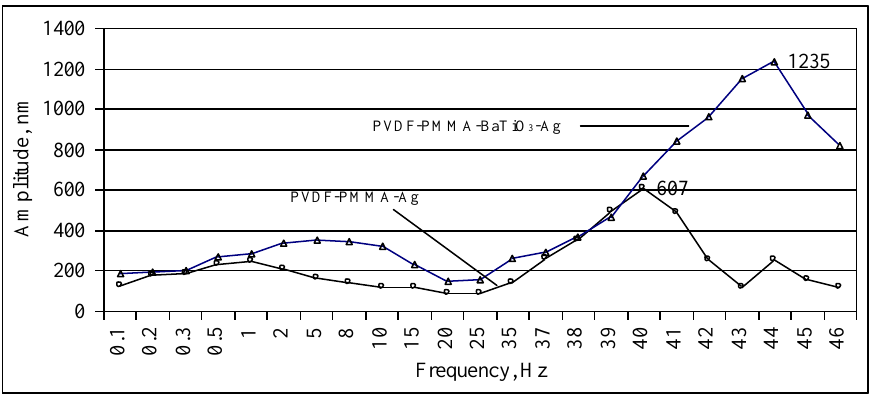
Figure 4. Amplitude—frequency dependence of the elements (voltage 130